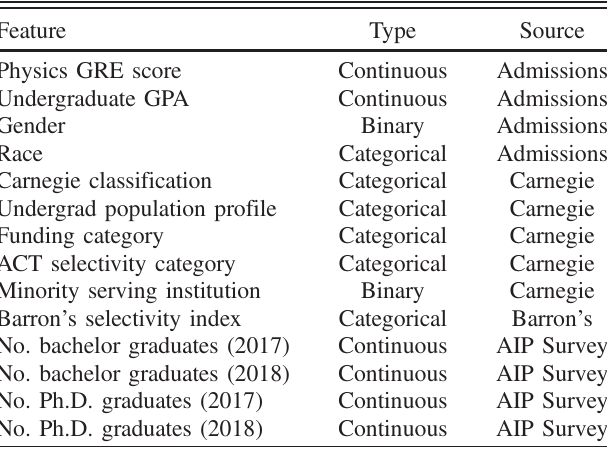
TABLE II. A summary of the features used in this study. Feature